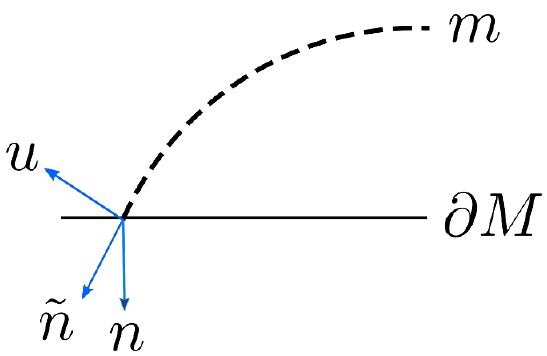
Figure 1 . Illustration showing u the unit normal to m , ~ n the unit normal to @m , and n the unit normal to the bulk time slice boundary @M at @m